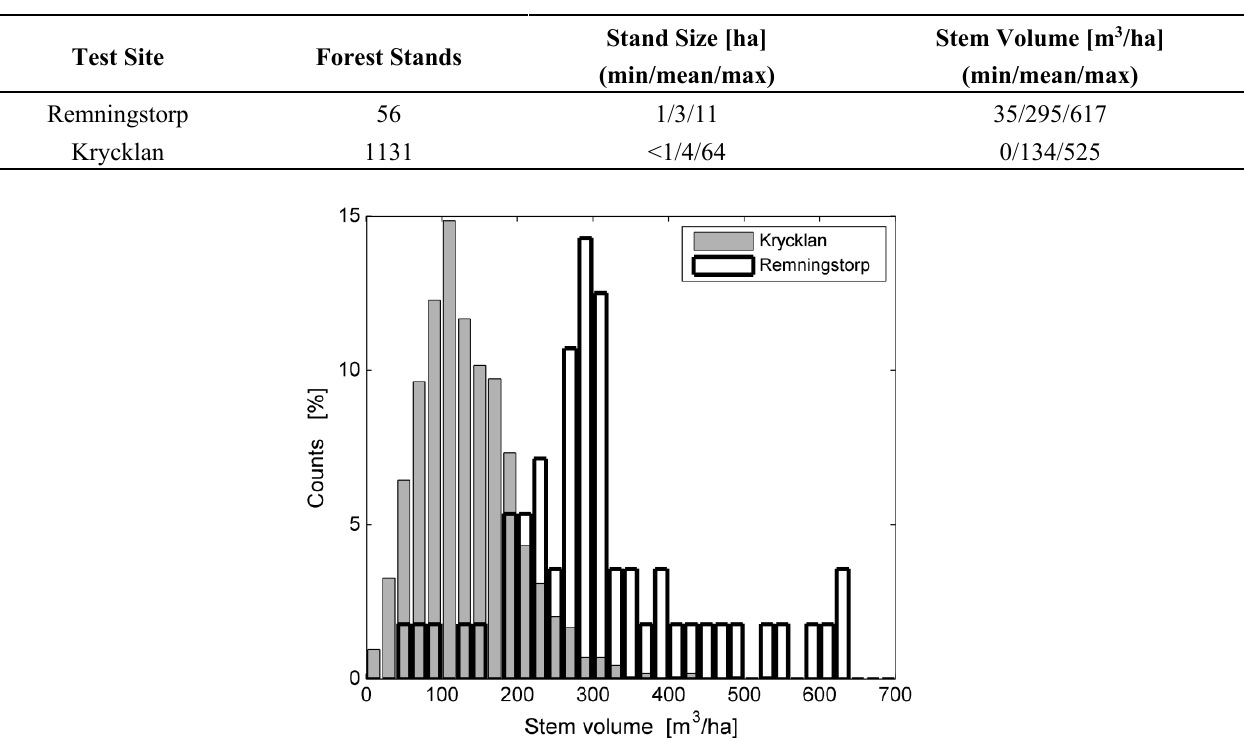
Table 1. Distribution of stand size and stem volume in the forest field inventory data used in this study for the test sites of Remningstorp and Krycklan.